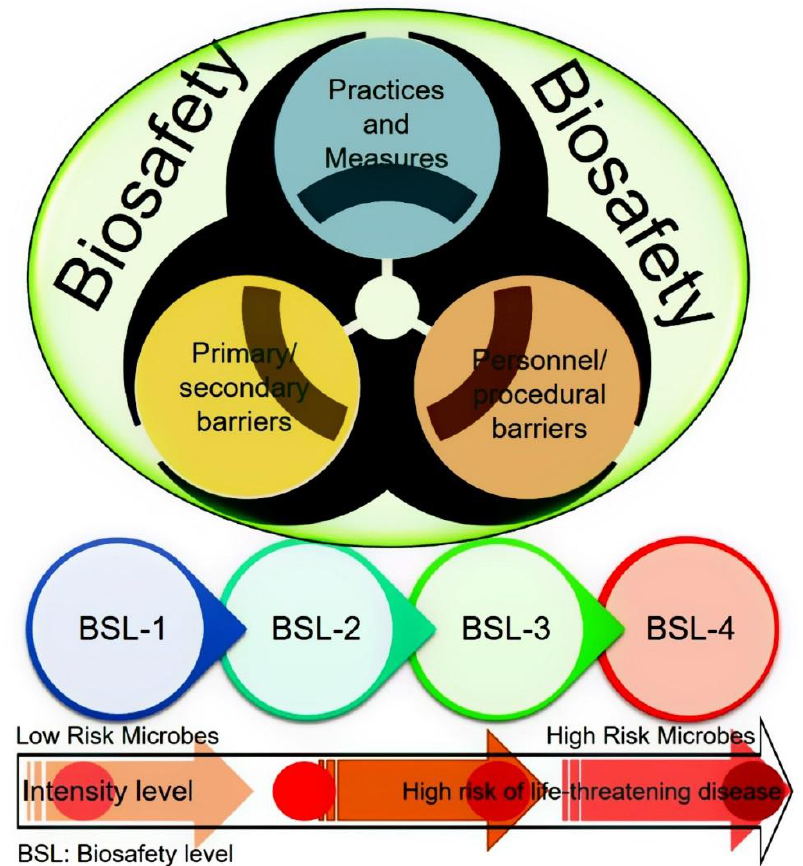
Figure 2. A schematic representation of a biosafety concept and four biosafety levels (BSL) with their risk intensity.